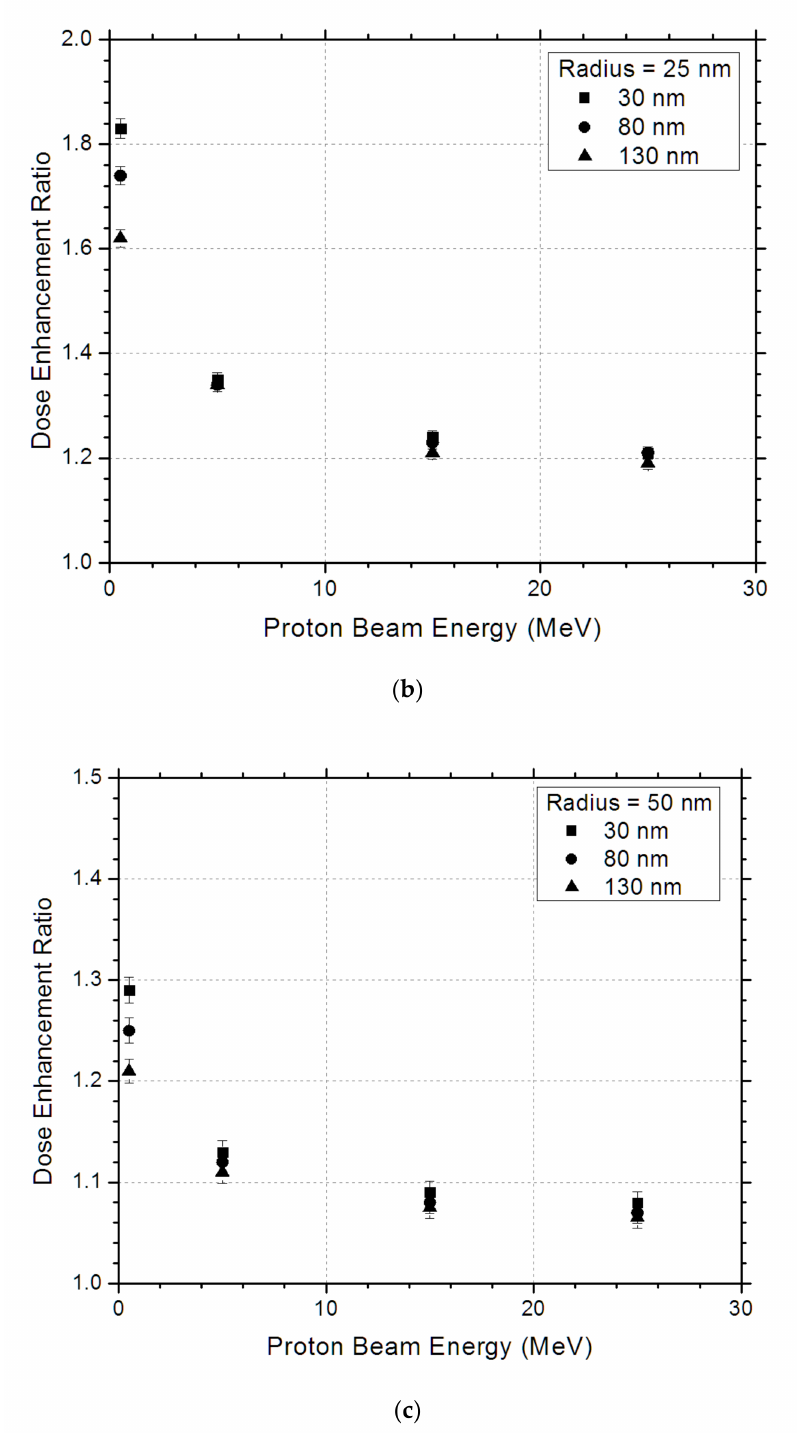
Figure 2. Dependence of dose enhancement ratio on proton beam energy (0.5–25 MeV). The distance between the gold nanoparticle and DNA was changed to 30, 80 and 130 nm, while the nanoparticle radius was changed to ( a ) 15, ( b ) 25 and ( c ) 50 nm in MC